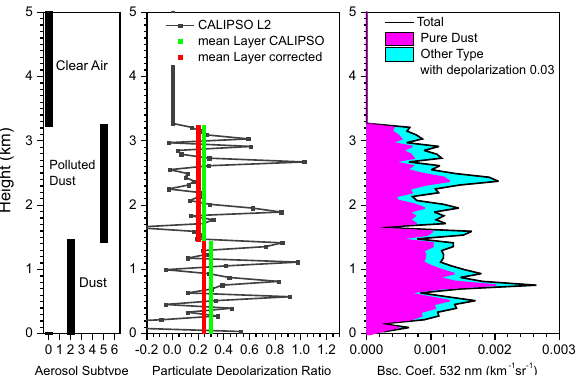
Fig. 5. Example of the application of Tesche et al. (2009) method- ology for the discrimination of pure dust from dust mixtures. Left: aerosol type. Middle: particle depolarization ratio (black line), mean layer depolarization reported by CALIPSO (green line) and mean particle depolarization ratio recalculated by the mean layer total and perpendicular backscatter coefficients (red line). Right: backscatter coefficient separation for pure dust (in magenta color) and “other” aerosol type (in cyan color).